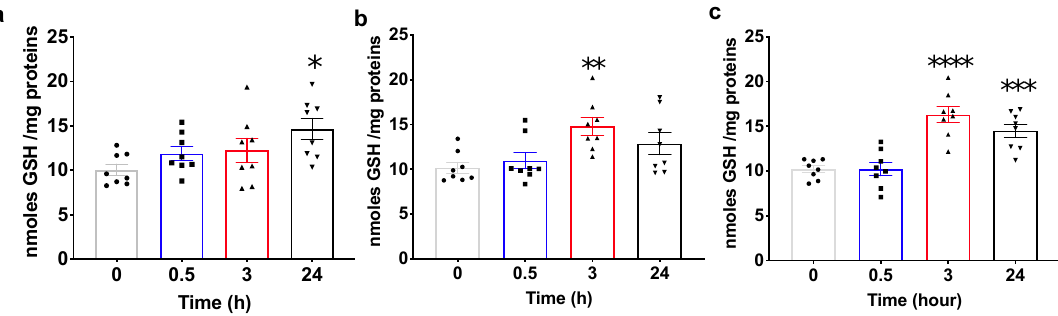
Figure 4. Changes in intracellular glutathione levels in human PBMC from different groups of healthy subjects after one hour of oxygen exposure in ( a ) mild (30% O 2 ), ( b ) high (100% O 2 ) and ( c ) very high hyperoxia (140% O 2 ). The histograms display the nmole of GSH for mg of protein (mean ± SEM) in comparison to baseline (Time 0), which was set at 10. * p < 0.05, ** p < 0.01, *** p < 0.001, **** p < 0.0001 vs. base line before oxygen exposure (time 0), for one-way ANOVA followed by Dunnett’s post hoc test.